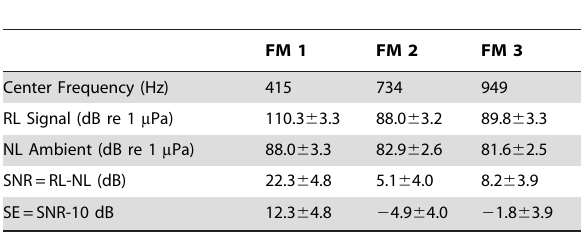
Table 2. Received level (RL) measurements over full bandwidth of OAWRS FM pulses, ambient noise (NL) measurements over the same bandwidths, signal-to-noise ratios (SNR) and signal excess (SE) (mean 6